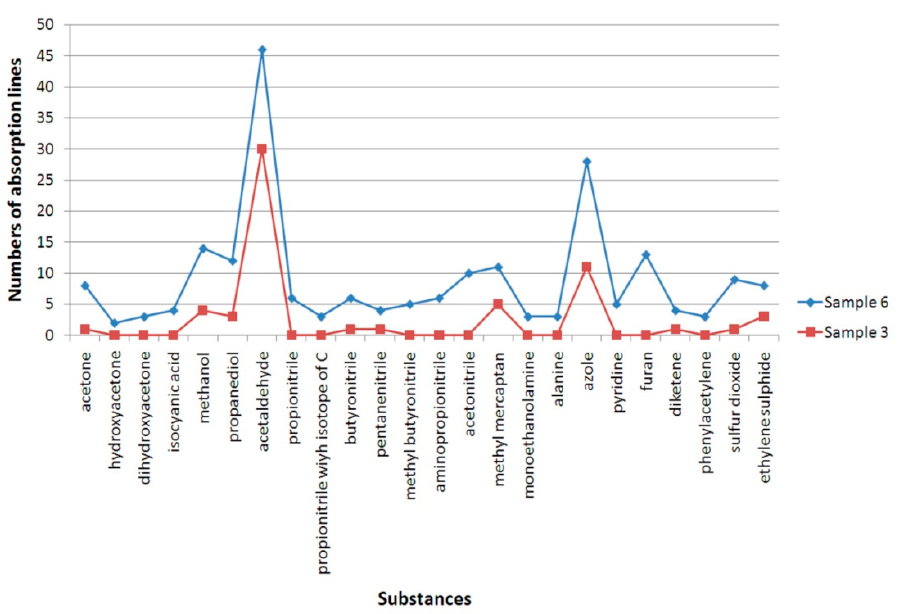
Figure 6. Comparison of the chemical composition of thermal decomposition products of polyp samples (Sample 6) and relatively healthy tissue (Sample 3) taken from a child.